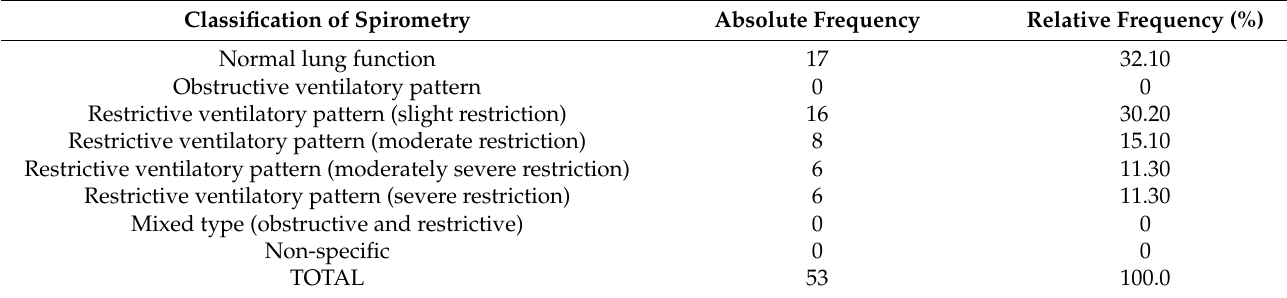
Table 3. Spirometry results: classification of the ventilatory pattern.